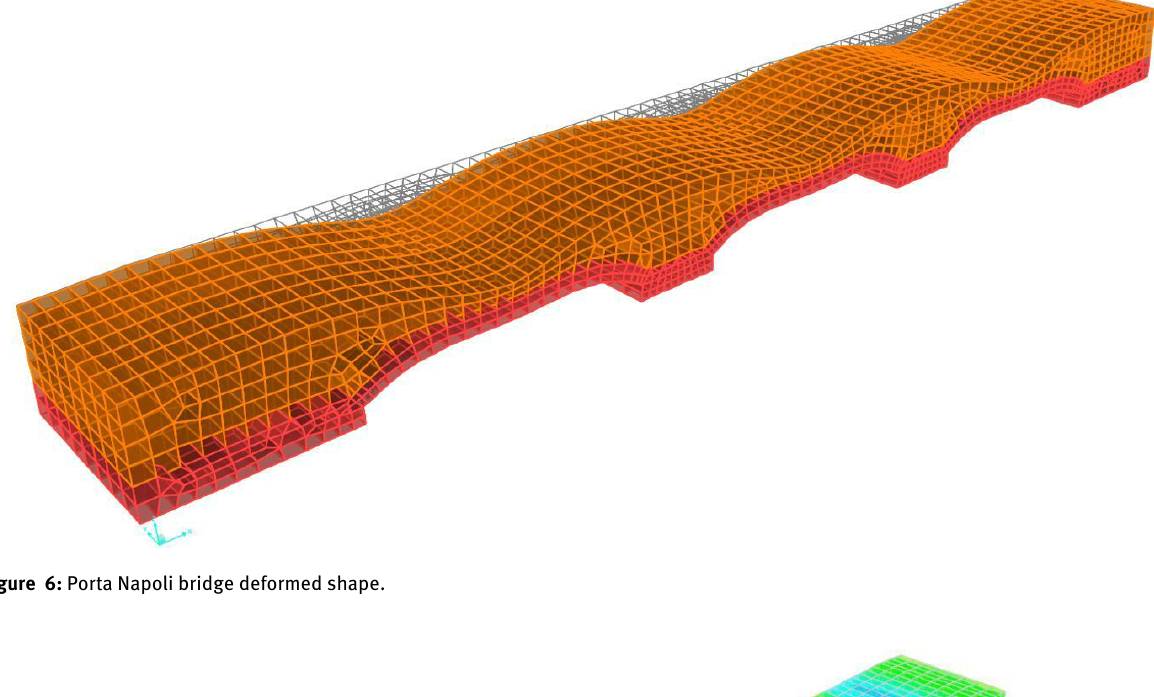
tion, which occurs, under perfect symmetry, at the forma- tion of the fourth